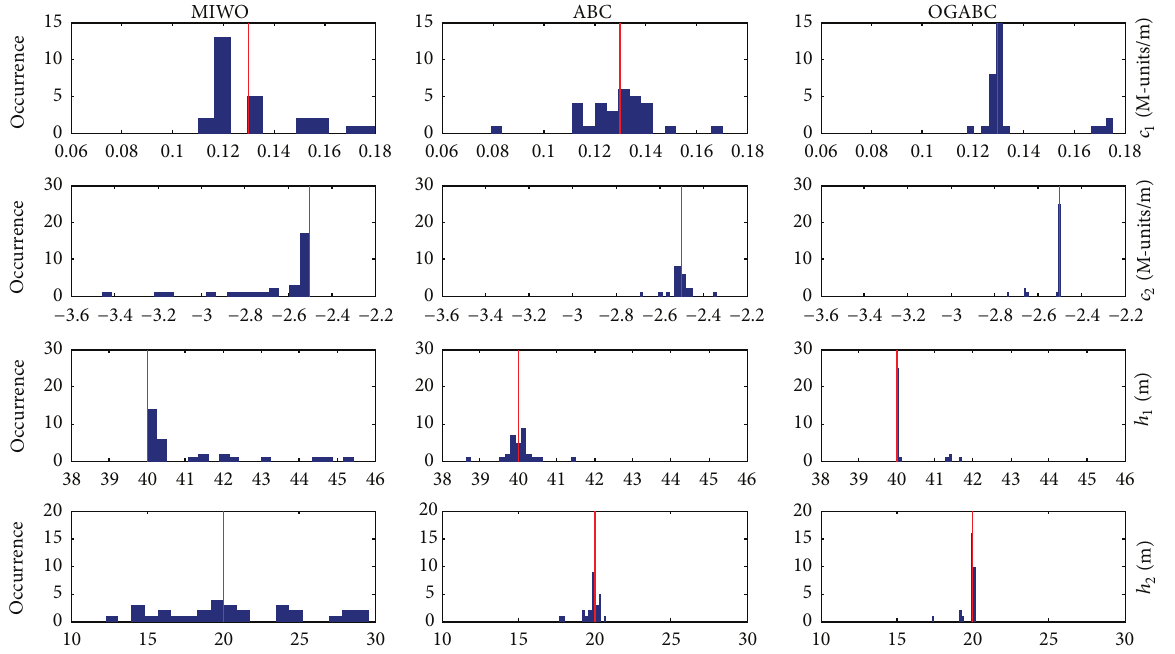
Figure 3: The comparison of the histograms of the inversion results for different algorithms with the noise level of 1dB.